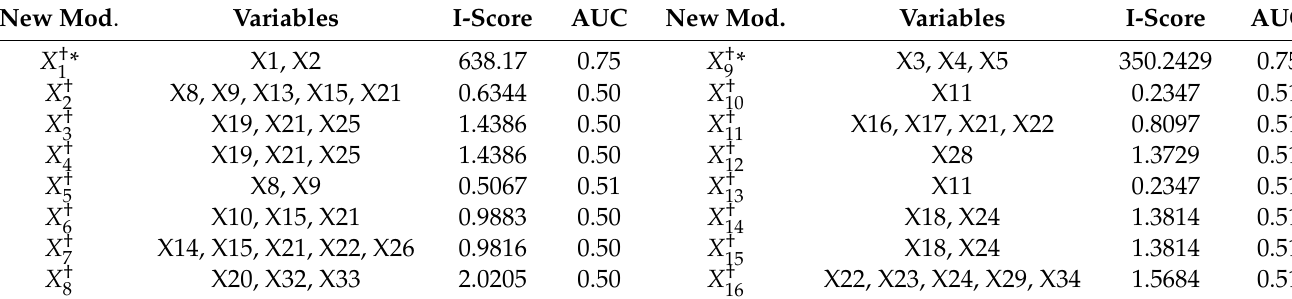
3, Table 4. Interaction-based convolutional layer. For an artificial data set with 6 2 = 36 variables and a window size of 3 × we create 16 new features that can be shaped into 4 4. The procedure of generating these 16 new features follows the same × procedure as in Table 3. The only difference is the window size, i.e., here, we use 3 3. In other words, we are able to create × while b = 1,2, . . . ,16 . The asterisk indicates extremely influential variable module(s). For each variable module, we X † b { } also present the AUC value (see Section 4.4 for a detailed discussion of AUC values) assuming a classifier built using this variable module